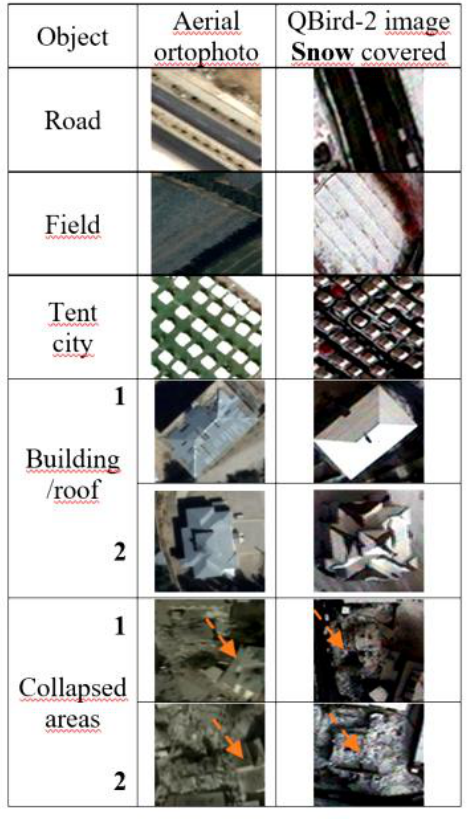
Figure 2: Seasonal effects in the land cover/use classes in the Quickbird-2